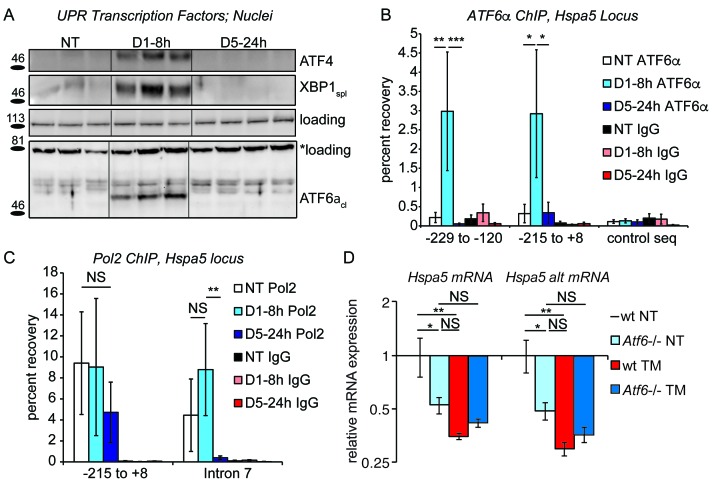
Chronic stress silences ATF6α-dependent transcription.(A) After treatment of mice with 0.025 mg/kg TM for either 8 hr or 5d, nuclei were isolated from liver lysates and probed with antibodies against ATF4, XBP1, or ATF6α. Specificity of all antibodies was confirmed by immunoblot from knockout or overexpression cells or liver lysates (not shown). The loading control for ATF4 and XBP1 blots was PARP. The loading control for the ATF6α immunblot is a nonspecific background band (*). (B) After TM treatment as in (A), control Ig or antibodies against ATF6α were used to immunopurify the Hspa5 promoter region, which was then amplified by qPCR using primers directed against two overlapping regions in the promoter containing the ER stress elements (ERSEs) or a control sequence. Number is given relative to the transcriptional start site. n = 3–4 animals/group (C) Same as (B), except ChIP was performed using antibodies against RNA Polymerase 2. The −215 to + 8 regions detects poised polymerase and so Pol2 binding does not change, while the Intron seven region (+2727 to+2906) detects elongating Pol2. (D) Wild-type or Atf6-/- mice were treated with 0.025 mg/kg TM or vehicle for 5d. qRT-PCR expression of Hspa5 in the liver was assessed using both primer sets. Hspa5 expression was suppressed to comparable levels by either chronic stress or deletion of ATF6α, but chronic stress had no effect in Atf6-/- animals. n = 3–5 animals/group.DOI:
http://dx.doi.org/10.7554/eLife.20390.00710.7554/eLife.20390.008Figure 3—source data 1.Contains raw and transformed Ct values for qPCR and qRT-PCR experiments in Figure 3B–D.